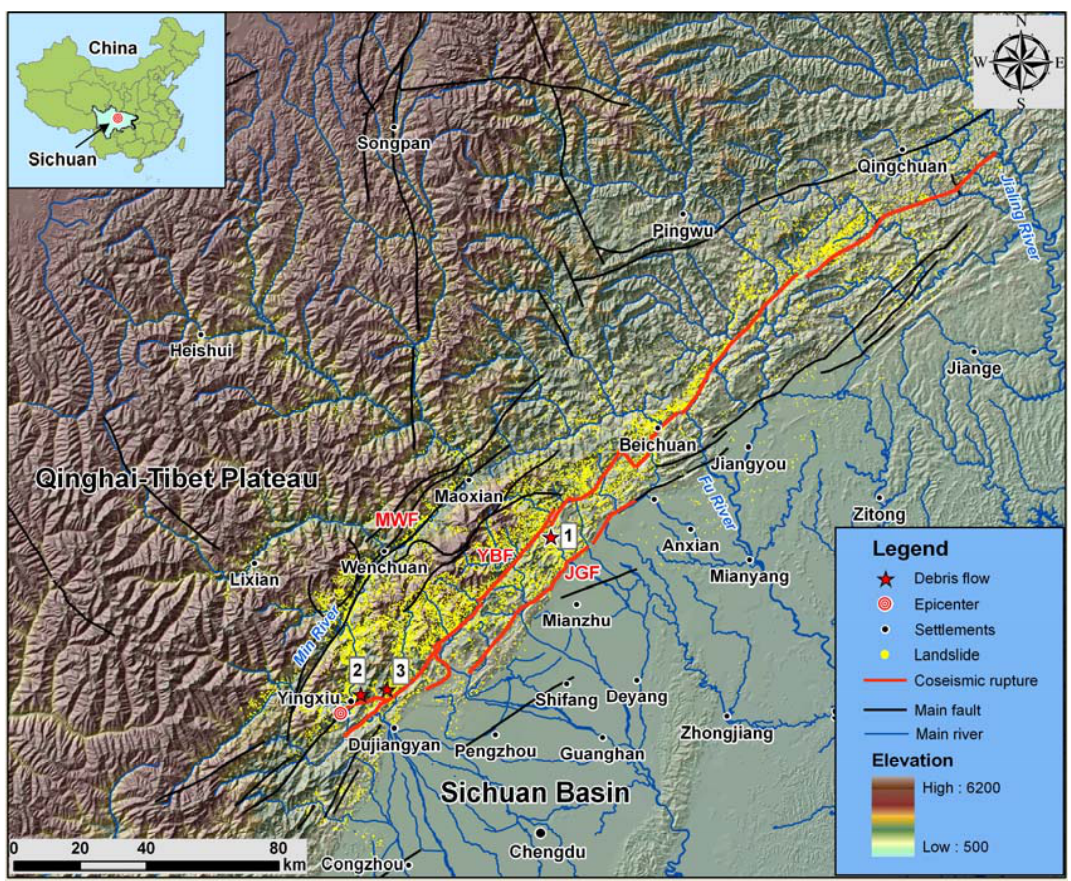
Fig. 1. Distribution map of landslides triggered by the Wenchuan Earthquake and three catastrophic debris flows triggered by the rainstorms on 13 August 2010 (MWF: Maoxian-Wenchuan Fault; YBF: Yingxiu-Beichuan Fault; JGF: Jiangyou-Guanxian Fault. 1: Wenjia gully and Zoumaling gully debris flows near Qingping Town; 2: Hongchun gully debris flow; 3: Longchi debris flow). The landslide distribution map was derived from a rapid landslide inventory made by Huang and Li (2009).